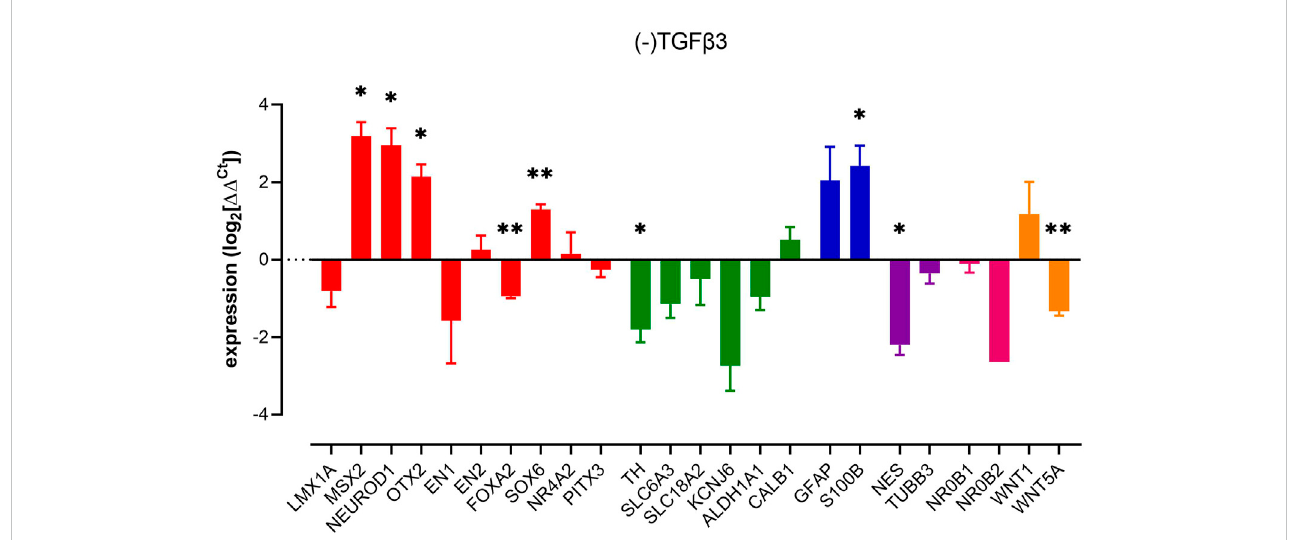
FIGURE 2 Impact of removal of TGF β 3 upon pluripotent stem cell-derived dopaminergic neuron cultures. Columns show mean (+s.e. mean) data normalized to HPRT1 and TBP and expressed as fraction of (+) TGF β 3 control (from matched differentiations). Statistical analysis was via one sample t-tests ( n = 3 biological replicates). Graphs show mean +/- s. e. mean changes; * = p < 0.05, ** = p < 0.01 and *** = p < 0.001.